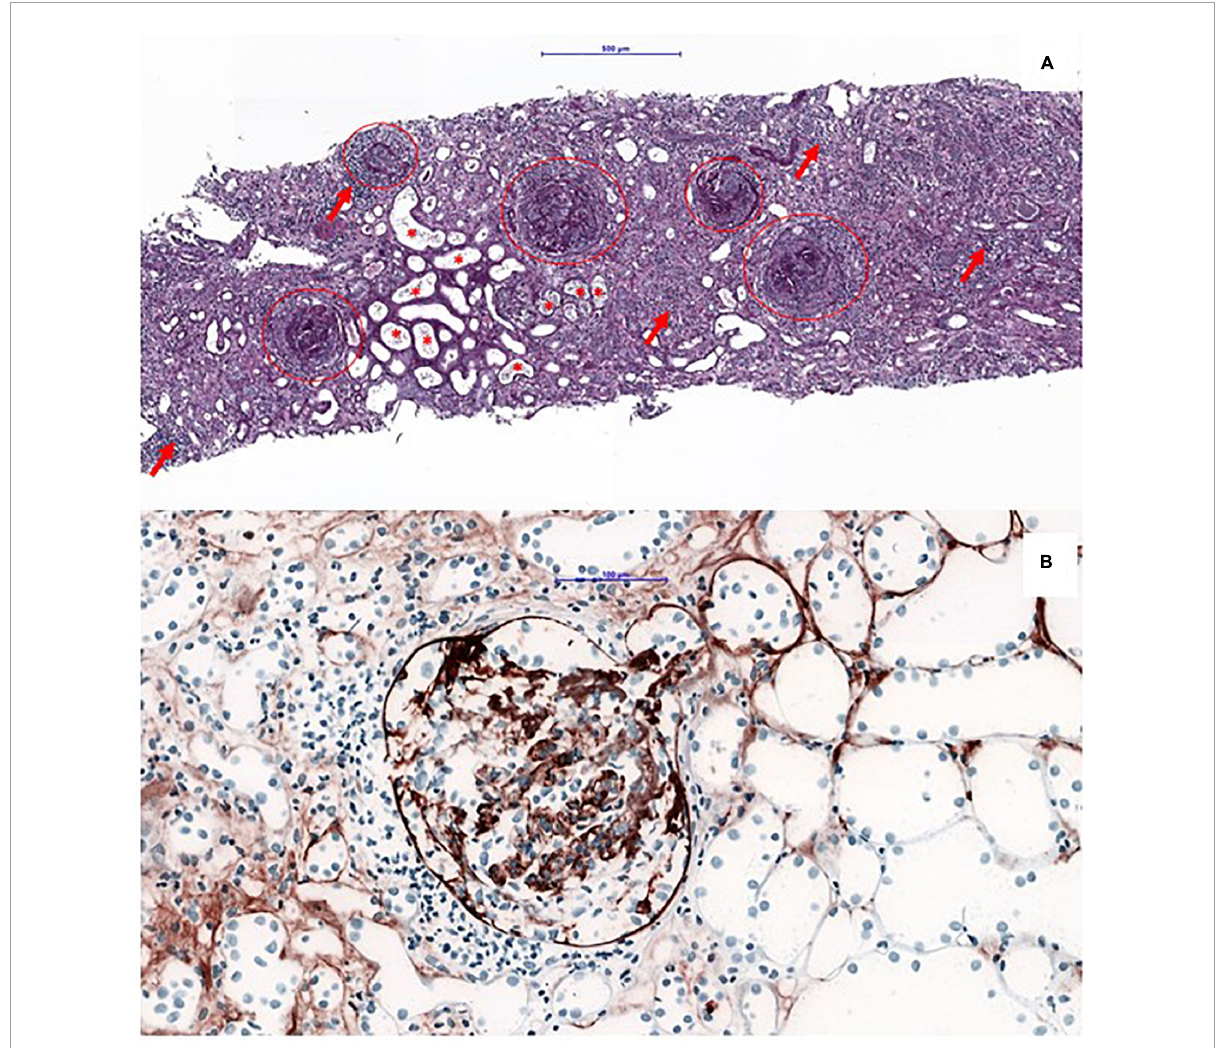
FIGURE1 Kidney biopsy: an overview of a PAS-stained kidney biopsy, showing large cellular crescent present in all glomeruli (as highlighted by the circles), in line with a severe presentation of anti-glomerular basement membrane (anti-GBM) disease. Concomitant tubulo-interstitial nephritis (arrows) and signs of severe acute tubular injury with red blood cells within the tubular lumina (asteriks). Bar = 500 µ m (A) . Immunohistochemical staining with the antibody against IgG, showing a linear staining pattern of the glomerular basement membrane (B)